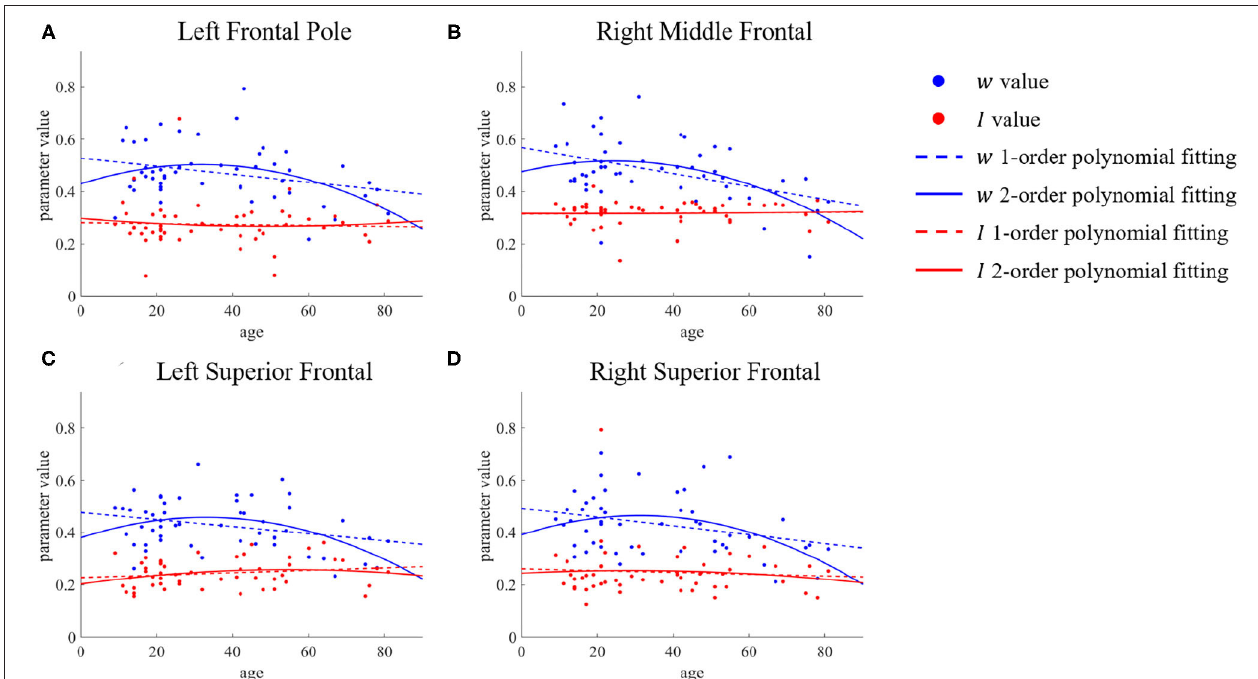
FIGURE 5 | ROIs with differences in first- and second-order polynomial fits of recurrent connection strength w . The points represent the parameter values, the dashed lines are the first-order polynomial fits, and the solid lines are the second-order polynomial fits. Blue indicates w and red indicates I . (A) Left Frontal Pole. (B) Right Middle Frontal. (C,D) Bilateral Superior